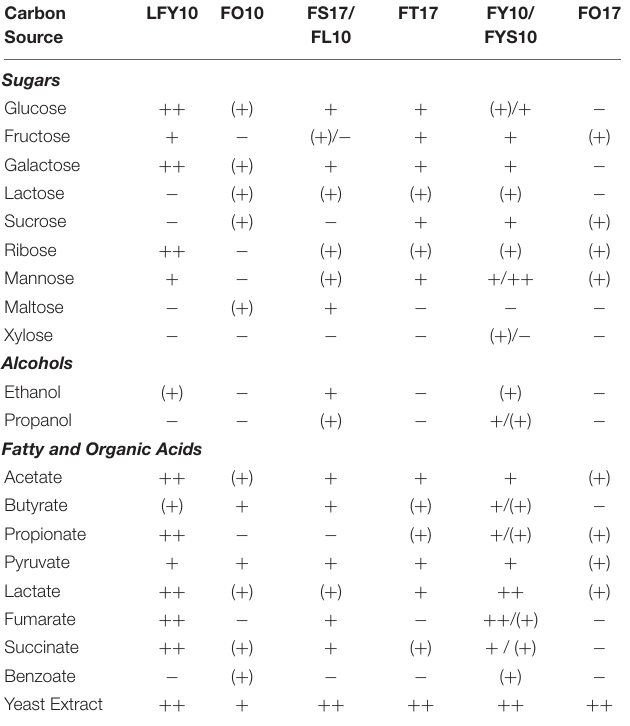
TABLE 2 | Carbon source utilization profile of Lake Fryxell isolates. ∗